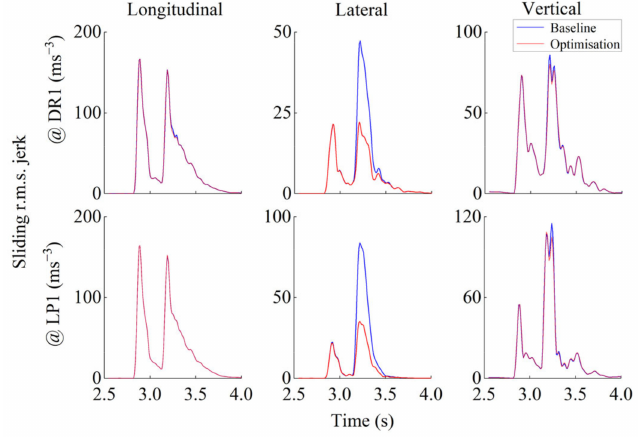
Figure 11. Comparison of sliding r.m.s. jerk at seat rails between the baseline and optimized models.